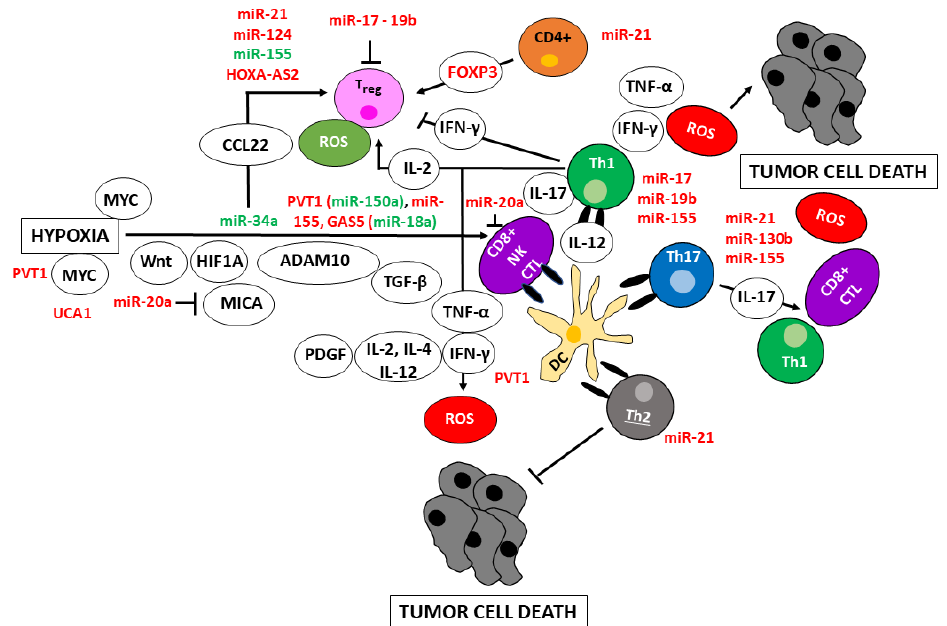
Figure 3. Control of T cell function and oxidative stress by noncoding RNAs. Cancer cells evade immune suppression by downregulating the activity of cytotoxic CD8 + T cells and NK cells, sup- pressing cytokines, and increasing T reg cells. Hypoxia-induced activation of Wnt/β -catenin ablates CD8 + T-cell function and suppresses anti-cancer immunity. In addition, hypoxia induces HIF1A, ADAM metallopeptidase domain 10, and MHC class I polypeptide-related sequence A (MICA), which, together with TGF- β, decreases NK cell activity. NK cells share properties with adaptive T cells, and together they induce cancer cell death through IFN- γ and tumor necrosis factor (TNF- α ).